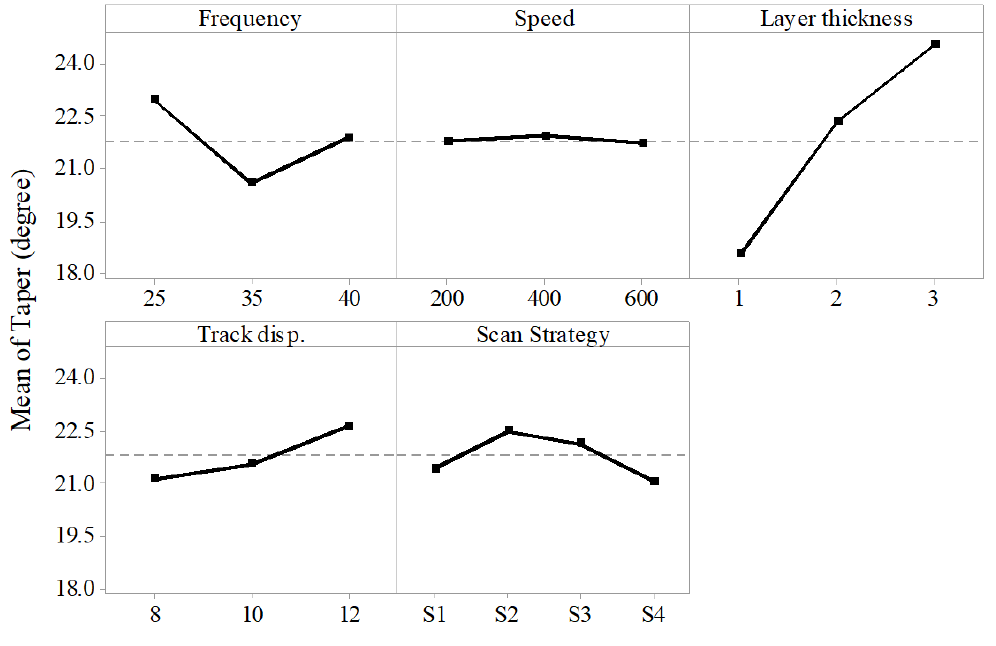
Figure 6. E ff ect of process parameters on taper angle of the microchannel. Figure 6. Effect of process parameters on taper angle of the microchannel . Figure 6. Effect of process parameters on taper angle of the microchannel .